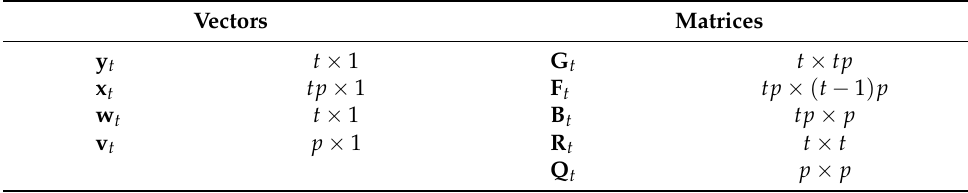
Table 1. Dimensions in the state space model of De Jong and Zehnwirth (1983). Vectors Matrices y